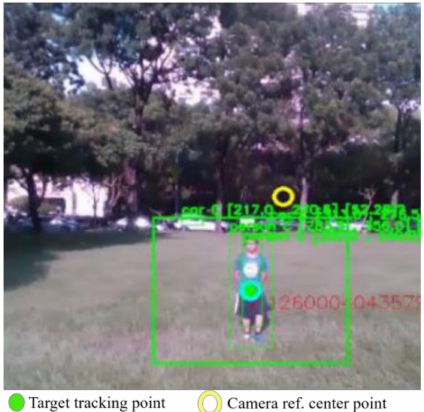
Figure 20. Front tracking of the target from the view of the